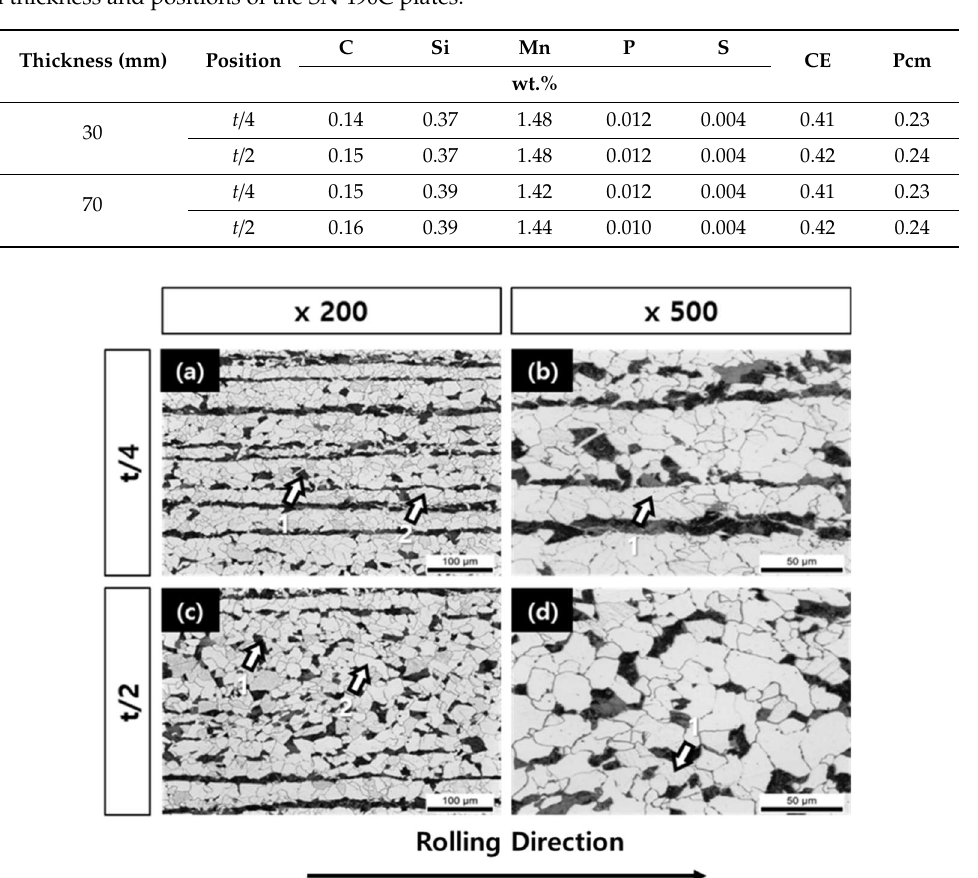
Figure 3. Optical micrographs of the 30 mm thick plate: ( a ) 1—pearlite, 2—ferrite; ( b ) 1—elongation of the grain; ( c ) 1—pearlite, 2—ferrite; ( d ) 1—elongation of the grain.